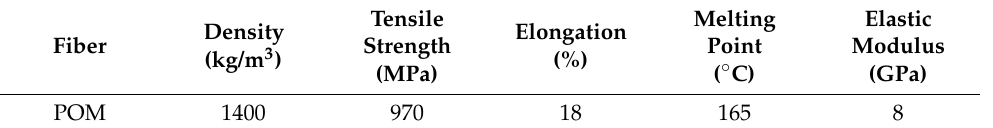
Table 3. Physical properties of the POM fiber.